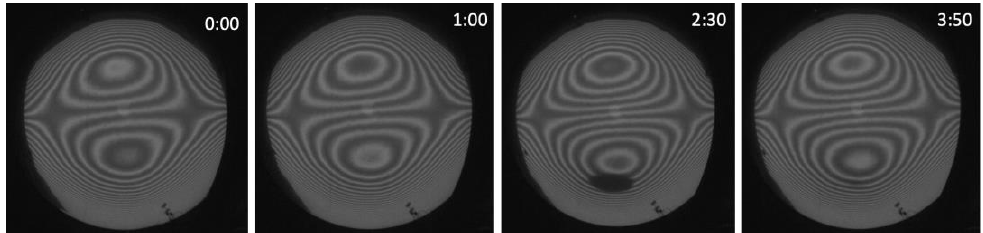
Figure 10 . After the unpunctured reflector (first subplot) is pierced, the number of fringes increases (second subplot). With knowledge of the testing distance ( z ≈ 3800 mm) and fringe width at the screen ( 𝜉 ≈ 9.62 mm ), one can count the number of fringes passing through a given pixel to coarsely estimate the slope change in y-direction. In the third subfigure, a shadow precludes slope measurement at this local surface region, indicating that the slope change exceeds the measurable dynamic range of the deflectometer in its current position. The shadow shrinks and grows at a low temporal frequency until it fully recovers and is measurable again without the subaperture data void. Chamber pressure increased from 0.84 Pa to 7.07 Pa after puncture.